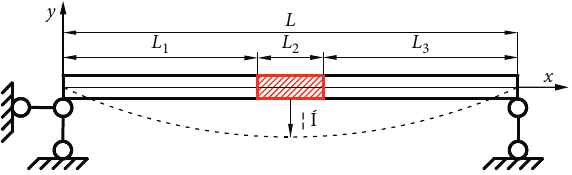
Figure 1: Simply supported beam with the damaged portion in